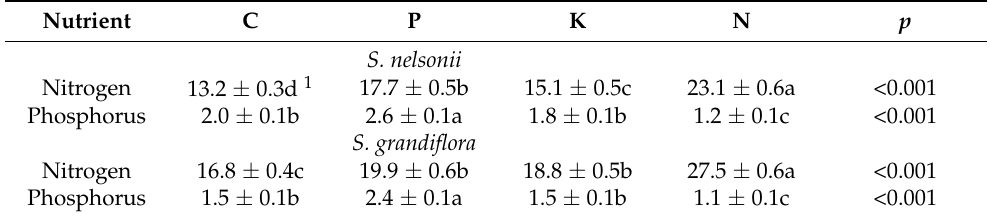
Table 3. The influence of N, P, or K fertilization on nitrogen and phosphorus concentrations (mg·g − 1 ) of Serianthes nelsonii and Serianthes grandiflora leaves. C = control; P = phosphorus fertilization; K = potassium fertilization; N = nitrogen fertilization. Mean ± SE, n = 6.